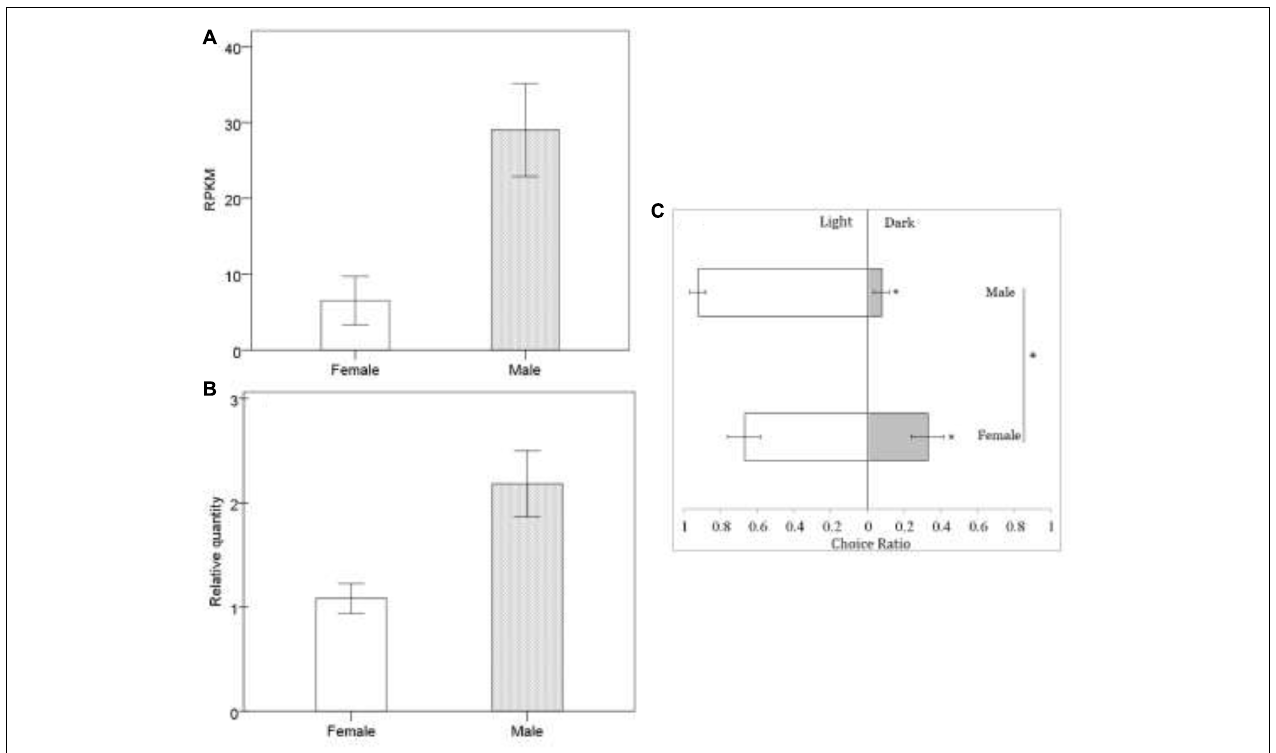
FIGURE 2 | Sexual difference in response to light at mRNA level (A,B) and behavioral level (C) . In transcriptomic data, we identified putative genes expressed using the reads per kb per million reads (RPKM) method. Quantitative real-time PCR (qRT-PCR) analysis was used to calculated the relative gene expression to further check the transcriptomic data, in which the differences in female and male were analyzed by the independent t -test. There was a highly significant correlation co-efficient of 0.885 between transcriptomic data and qRT-PCR data. Behavioral responses of Brachymeria lasus adults to dark or light were tested with phototaxis assays. The differences in female ( n = 24) and male ( n = 18) phototaxis were analyzed by the chi-square test. ∗ indicates p < 0.05. The error bars indicate standard errors.